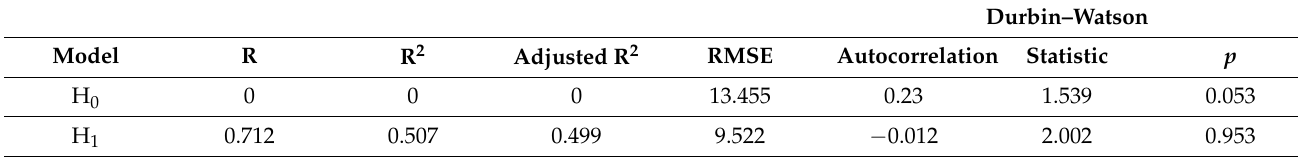
Table 9. Wet candle method and horizontal dry plate method—model.